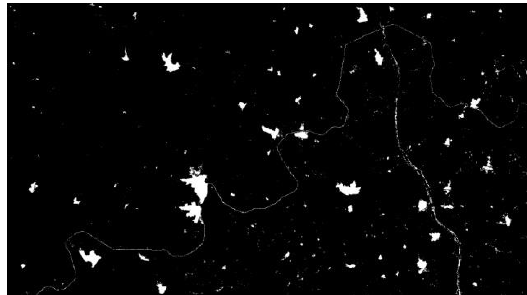
Figure 8: Nagarjuna sagar left canal branch from figure-7